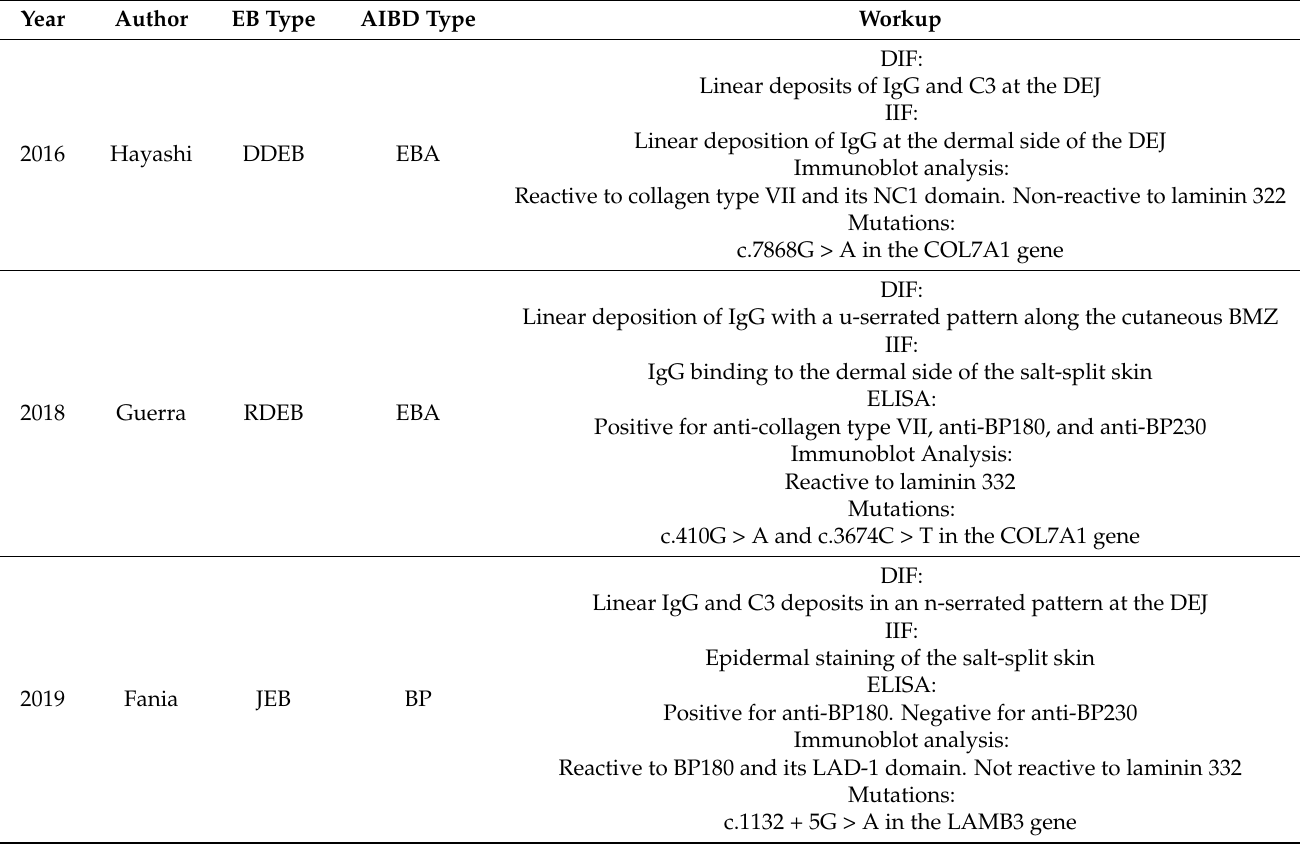
Table 3. Reported cases of confirmed cases of AIBD arising in patients with